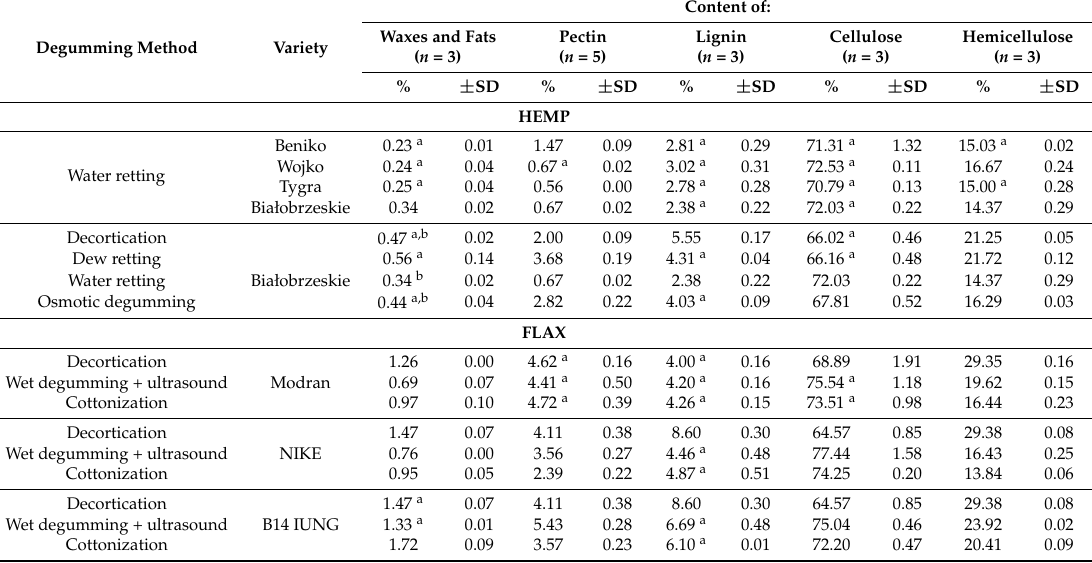
Table 1. Chemical composition of: water retted hemp fibers of Beniko, Wojko, Tygra and Białobrzeskie variety; hemp fiber of Białobrzeskie variety after dew retting, decortication, osmotically degumming and water retting and flax fibers of Modran, Nike and B14 IUNG variety after technological processes. Results are expressed as mean ± standard deviation (SD). Lower-case letters indicate significant differences at p ≤ 0.05 according to the Tukay’s HSD